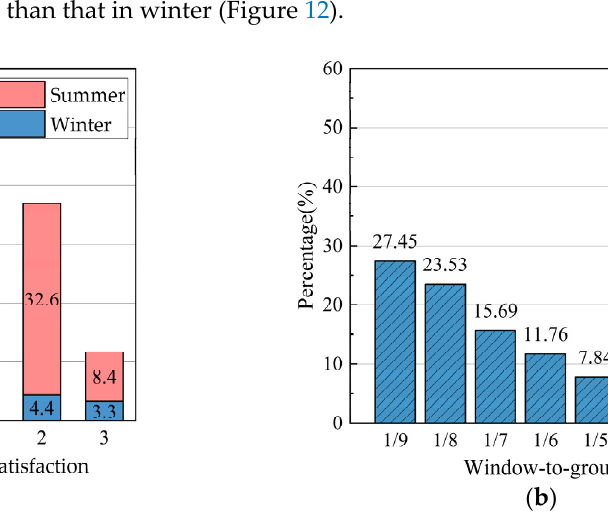
Figure 12. Results of the questionnaire survey on the indoor light environment of traditional houses in Xixinan Village. ( a ) Satisfaction distribution of indoor light environment. ( b ) Comparison of indoor windows and floor space in traditional residential houses.